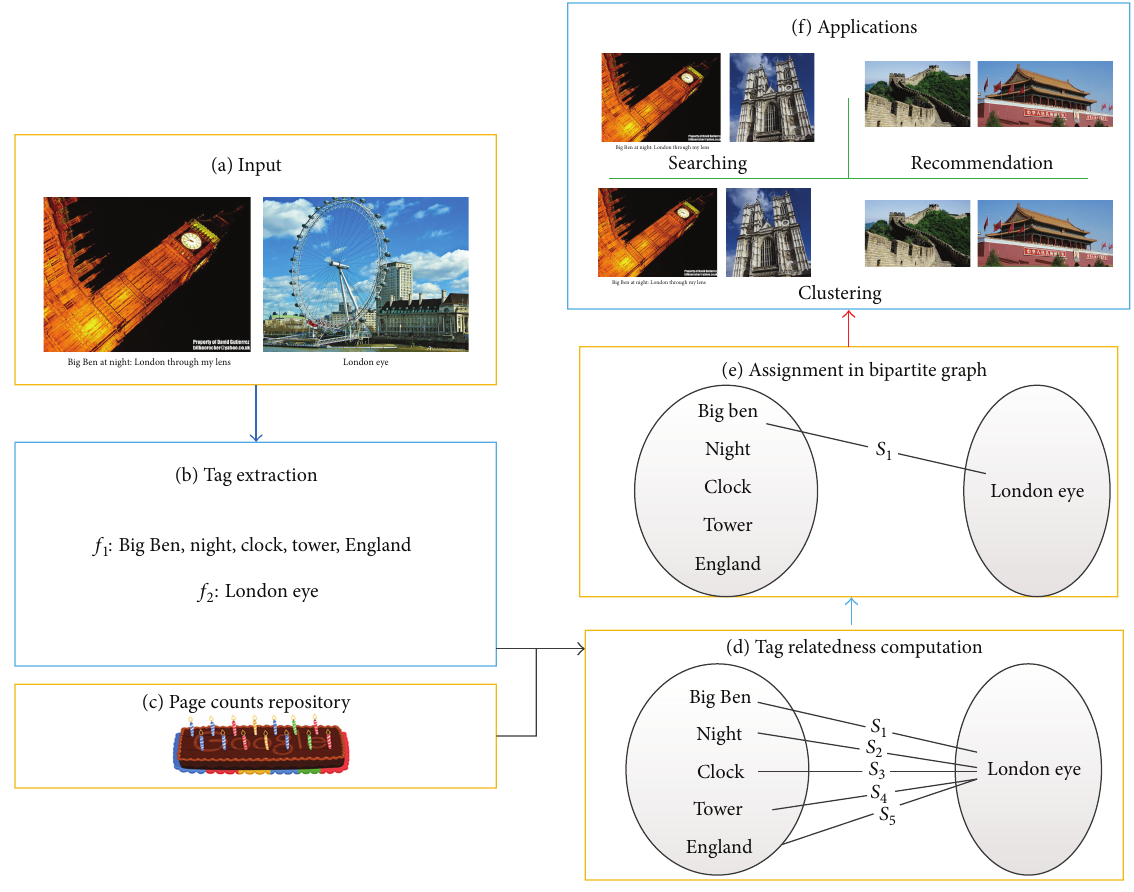
Figure 3: The illustration of the proposed method.